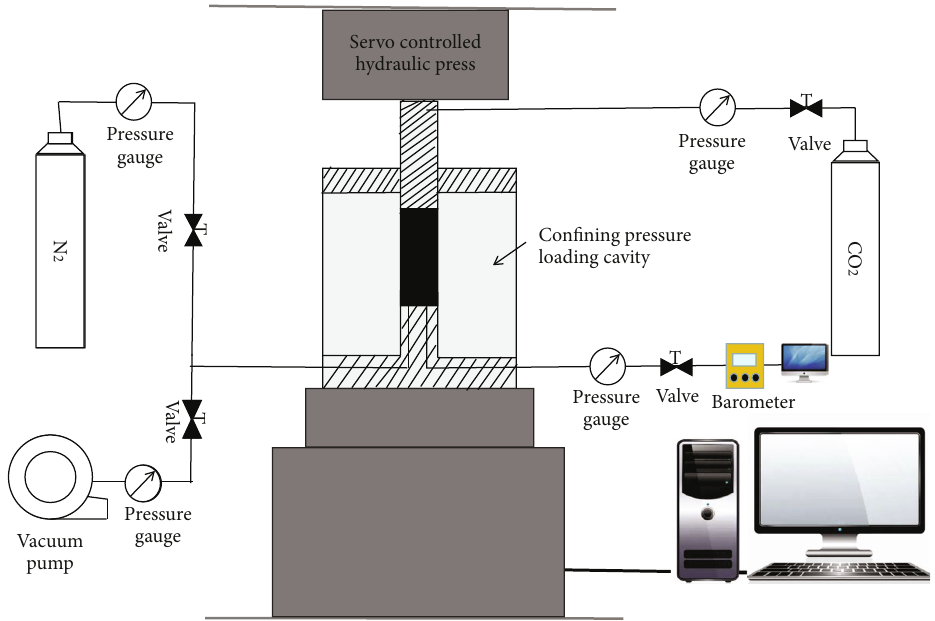
Figure 1: Schematic diagram of the experimental system.